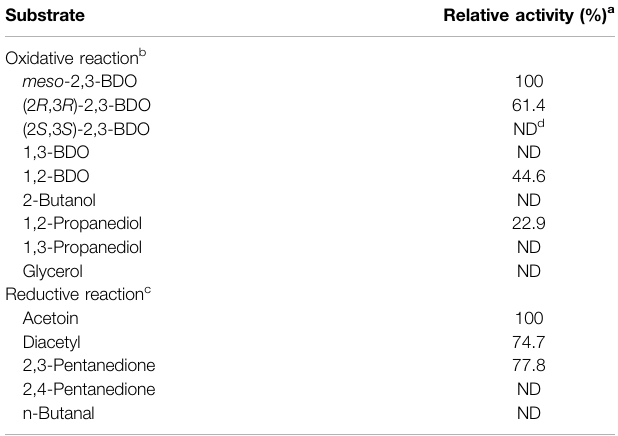
TABLE 1 | The relative activity of R , R -BDH toward different substrates. Substrate Relative activity (%) a